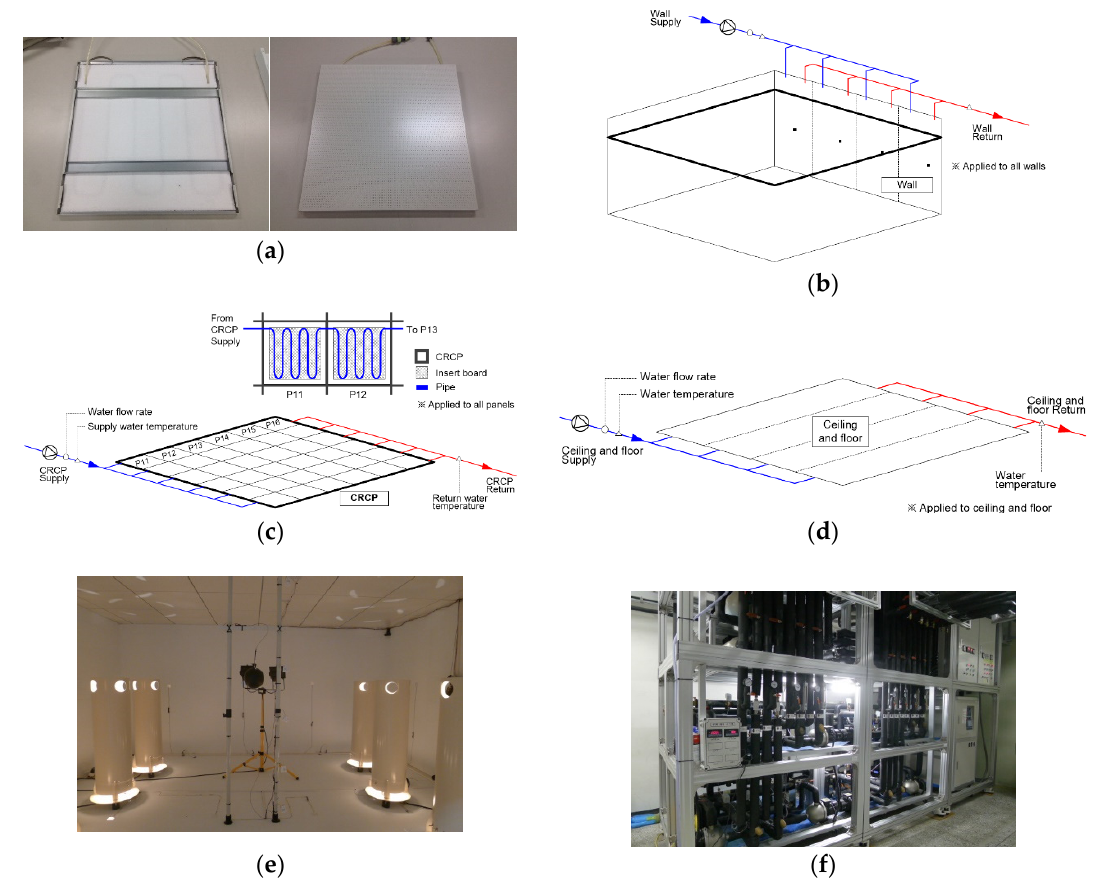
Figure 19. Experimental evaluation of the cooling capacity of the CRCP: ( a ) Cooling Radiant Ceiling Panel; ( b ) test cell wall distribution system; ( c ) CRCP joint and distribution system; ( d ) ceiling and floor distribution system; ( e ) indoor of test cell with wall temperature control; ( f ) heat source for CRCP and walls. Table 17. Boundary condition for cooling capacity evaluation experiments.